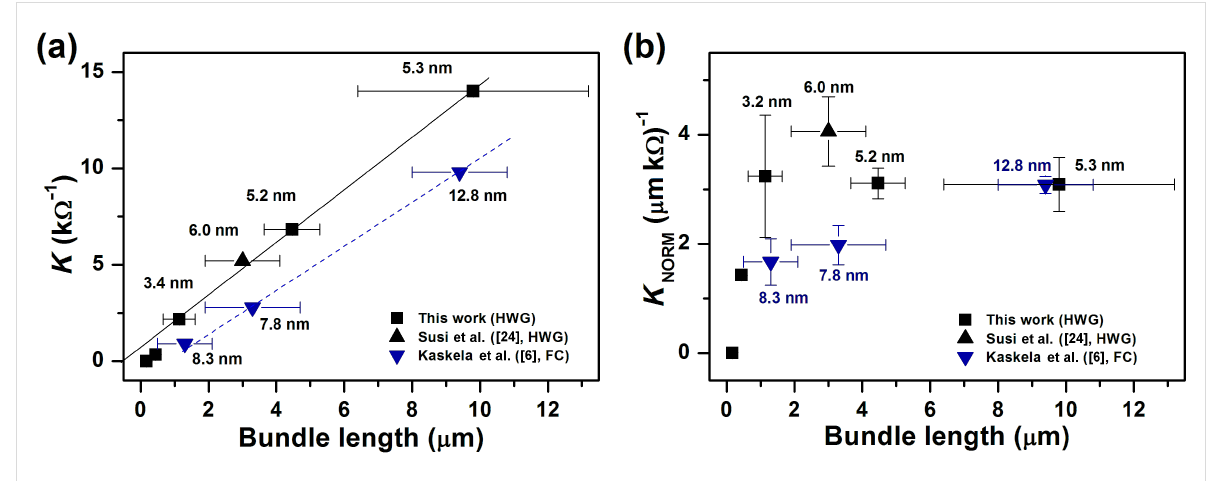
Figure 7: (a) The figure of merit K versus bundle length. A linear dependence of K on L bundle is observed, as expected from geometric scaling argu- ments combined with the Beer–Lambert law. The higher the K , the better the optoelectronic performance. (b) Normalized figure of merit K NORM versus L bundle . The apparent difference between the two datasets (black and blue) is greatly reduced.